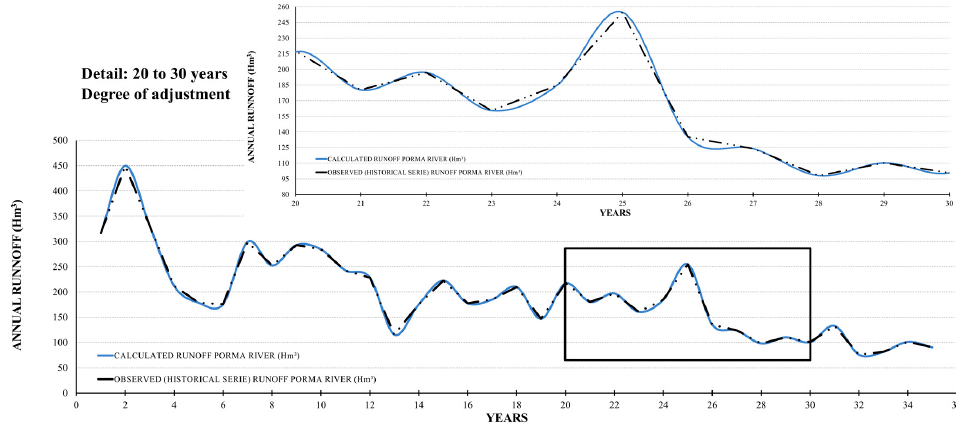
Figure 8. Predictive accuracy test of the temporal behavior by BNs. BN (calculated) vs. Historical runoff series (Observed).